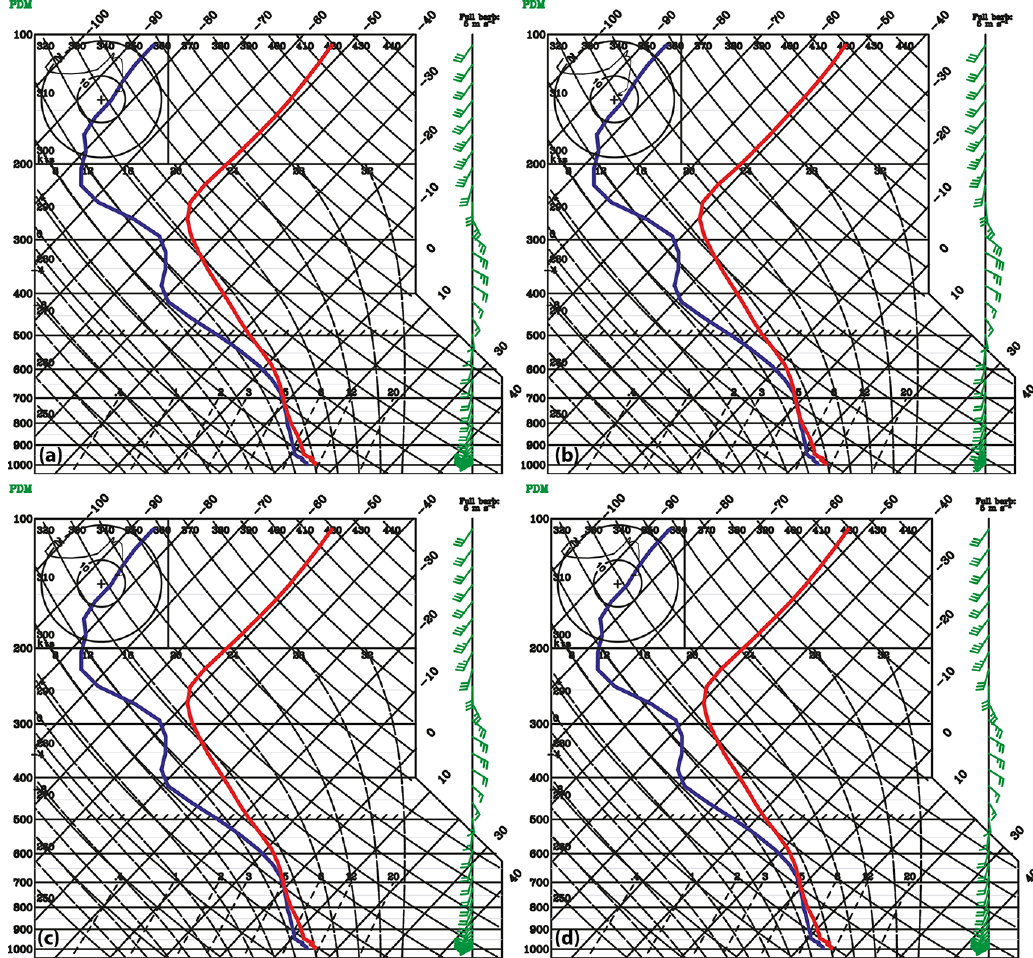
Figure 6. WRF sounding at 00:00UTC on 20 May 2008 at PDM for (a) CTL, (b) CON, (c) RAD, and (d)